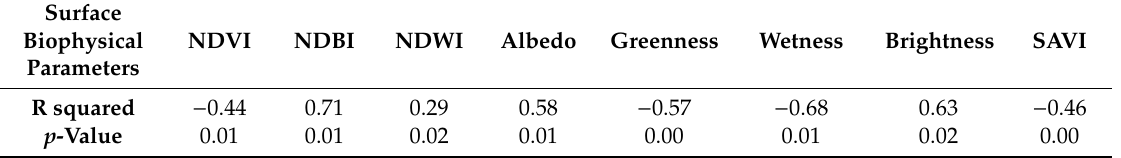
Table 2. Correlation coe ffi cient between the mean values of the NLST and mean normalized values of surface biophysical